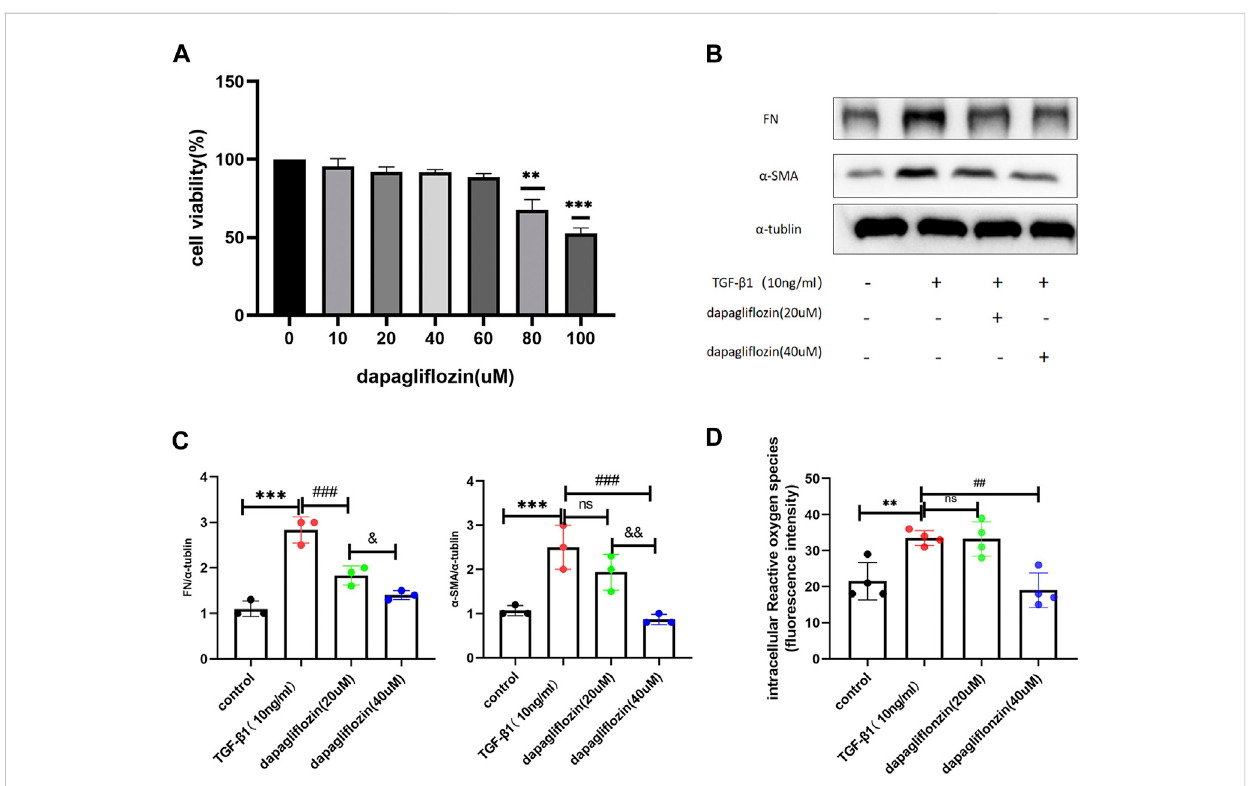
FIGURE 7 Dapagli fl ozin reduced the expression of renal fi brosis-related markers in HK2 cells stimulated by TGF- β 1. (A) CCK8 was used to evaluate thetoxicity of dapagli fl ozin to normal cells. (B, C) Western blot showing the expression of FN and α -SMA in HK2 cells in each group. (D) The ROS content in HK2 in eachgroup.*** p < 0.001TGF- β 1stimulatedgroupcomparedwiththecontrolgroup;Valuesaremeans±SD. ### p < 0.001dapagli fl ozintreatment group compared with TGF- β 1 stimulation group; and p < 0.05 20 uM dapagli fl ozin treatment group compared with 40 uM dapagli fl ozin treatment group; and p < 0.01 20 uM dapagli fl ozin treatment group compared with the 40 uM dapagli fl ozin treatment